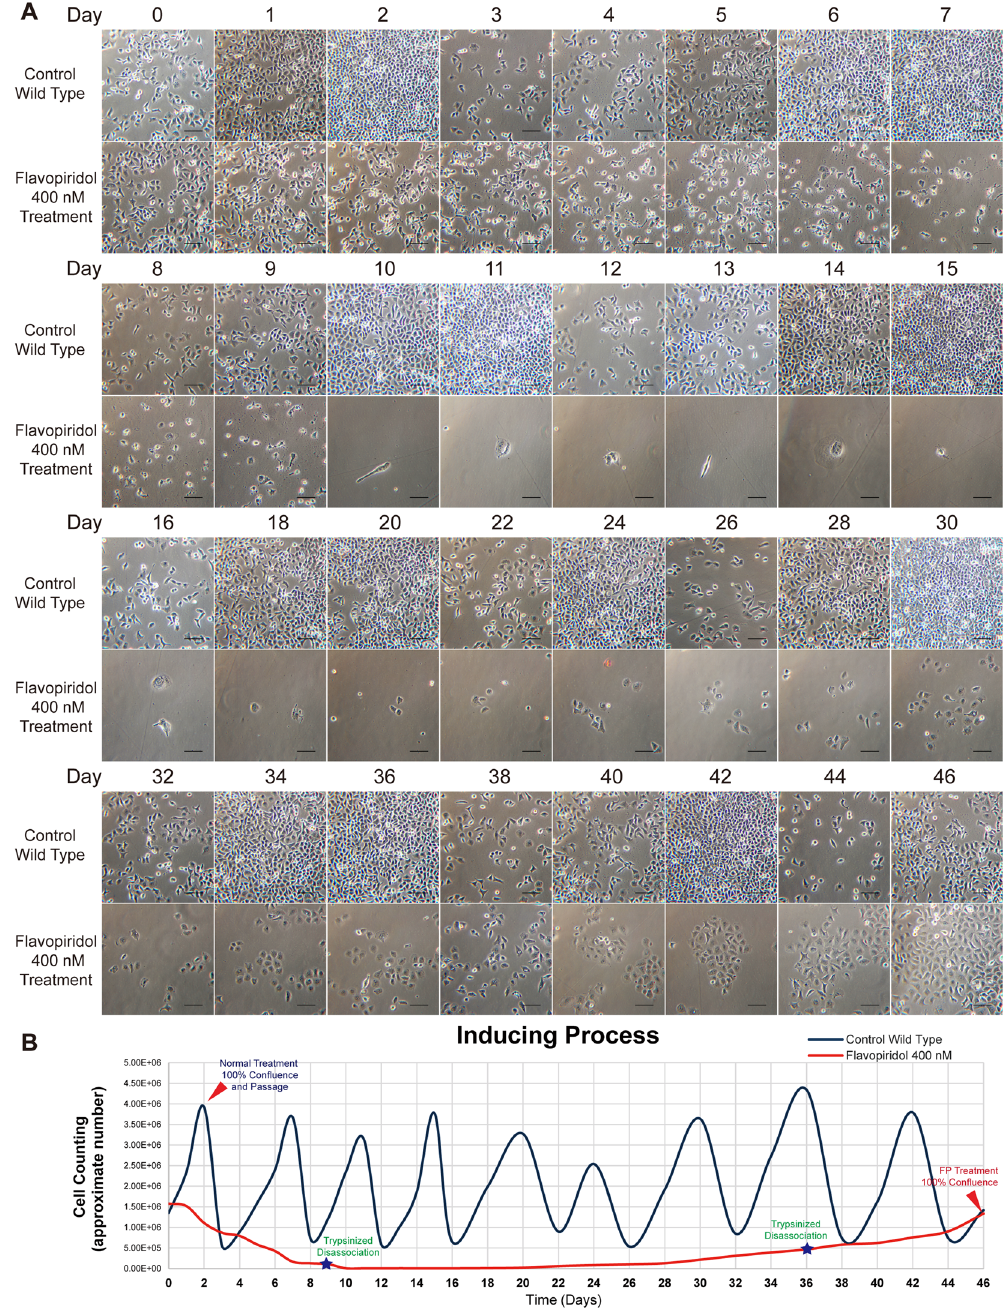
Figure 1. DU145 cells during the FP treatment adaptation process. ( A ) FP-resistant DU145 cells are developed through a 46 days’ adaptation process. The wild type DU145 cells are displayed as controls in the upper rows, and the DU145 cells exposed to 400 nM FP are shown in the lower rows. The scale bar equals to 100 µ m. ( B ) Line charts display the typical adaptation process. The dark blue- and red lines denote the approximate cell count fluctuations in a period of 46 days. The dark blue line represents the wild type DU145 cells, while the red line denotes the status when DU145 cells were treated with FP. The blue peaks denote each passage of DU145 WT cells, the red triangle represents cell confluence, and the blue stars denote trypsinized dissociation during the 400 nM FP